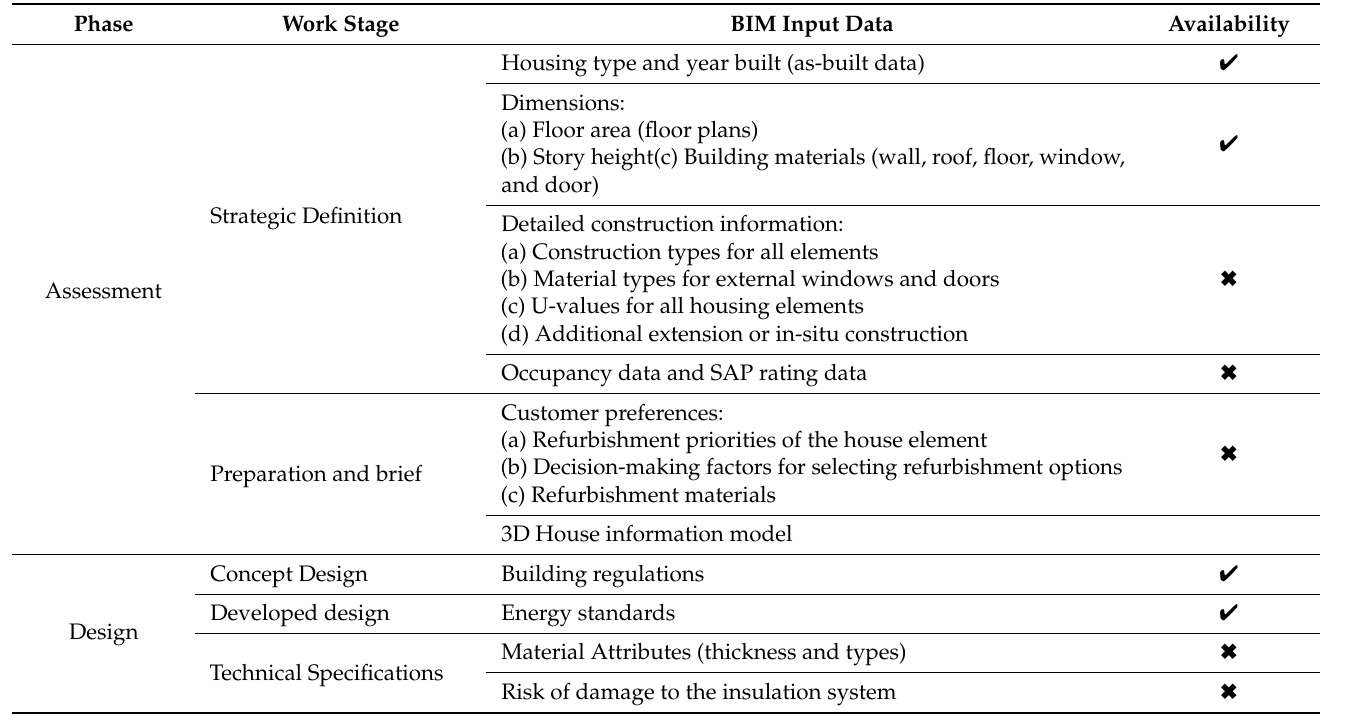
Table 7. BIM input